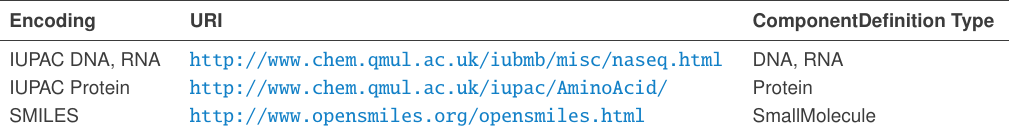
Table 1: URI s for specifying the encoding property of a Sequence , organized by the type of ComponentDefinition (see Table 2) that typically refer to a Sequence with such an encoding .